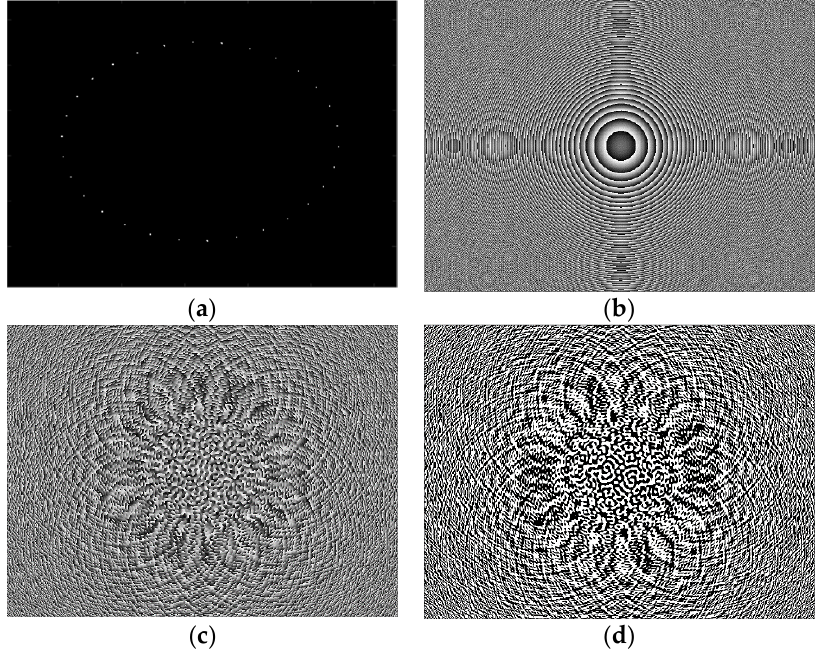
Figure 3. Scheme of binary hologram generation. ( a ) Centers of desired focus positions mapped to the SLM (Simulation). ( b ) Fresnel zone plate for focusing light to a single point at the desired distance. ( c ) Phase of the convolution of the complex-valued functions depicted in ( a , b ), i.e., of the desired complex-valued hologram. ( d ) Binary phase hologram as a result of binarizing the complex hologram in ( c ).